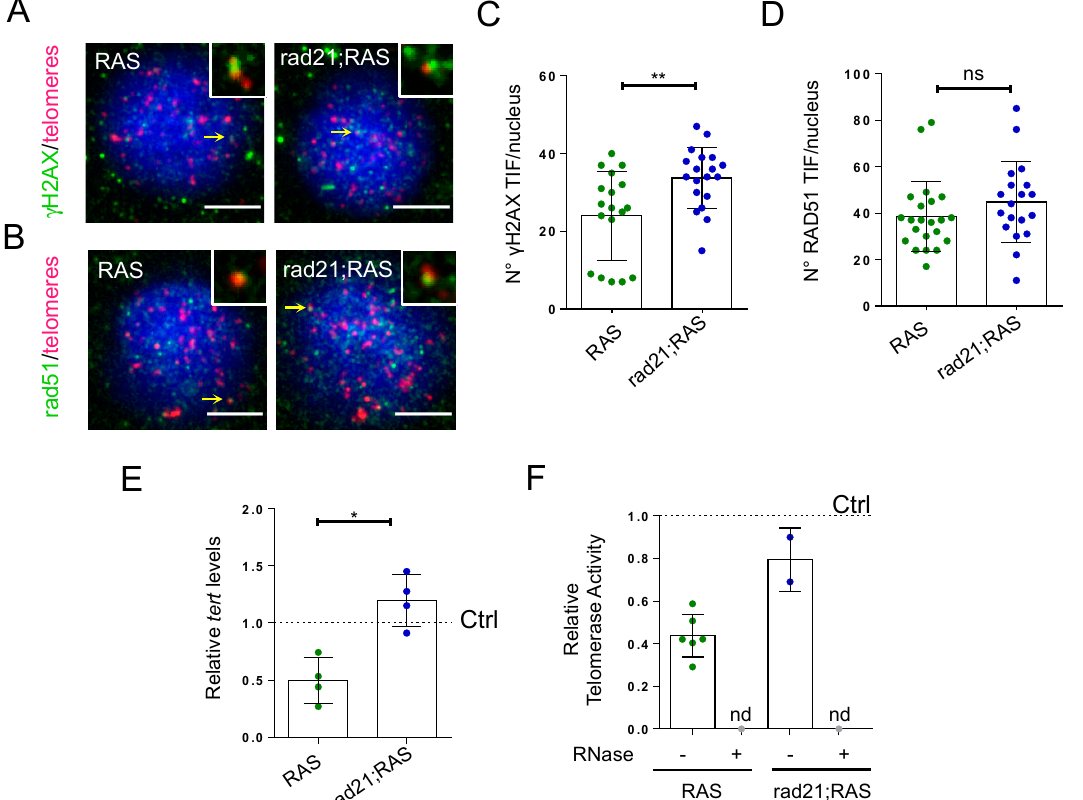
Figure 3. Rad21 depletion increases tert expression and γ H2AX TIFs in brain tumors. ( A ) Representative fluorescent microscope image of Q-FISH and γ H2AX immunostaining in RAS and rad21;RAS tumor cells. Scale bar: 5 µ m. Insets show examples of co-localization of the Q-FISH and antibody signals, in foci pointed by the yellow arrows. ( B ) Representative fluorescent microscope image of Q-FISH and Rad51 immunostaining in RAS and rad21;RAS tumor cells. Scale bar: 5 µ m. Insets show examples of co-localization of the Q-FISH and antibody signals, in foci pointed by the yellow arrows. ( C ) Quantification of the numbers of telomere foci which are positive for γ H2AX immunostaining (nuclei = 27), also known as TIFs, in RAS and rad21;RAS brain tumors cells. Each dot represents a nucleus. ** p < 0.01. ( D ) Quantification of the numbers of telomere foci which are positive for rad51 immunostaining (RAS nuclei = 22; rad21;RAS nuclei =19) in in RAS and rad21;RAS brain tumors cells. ns = not significant. Each dot represents a nucleus. ( E ) Expression of zebrafish tert mRNA in brain tumors measured by RT-qPCR. Values were normalized to rps11 mRNA levels and are relative to tert expression in control brains (dashed line set at 1.0). * p < 0.05. Each dot represents a sample. ( F ) Relative telomerase activity measured by Q-TRAP in control, RAS, and rad21;RAS brains. RNase treatment ( + ) was used as a negative control to confirm the specificity of the assay; each dot represents one